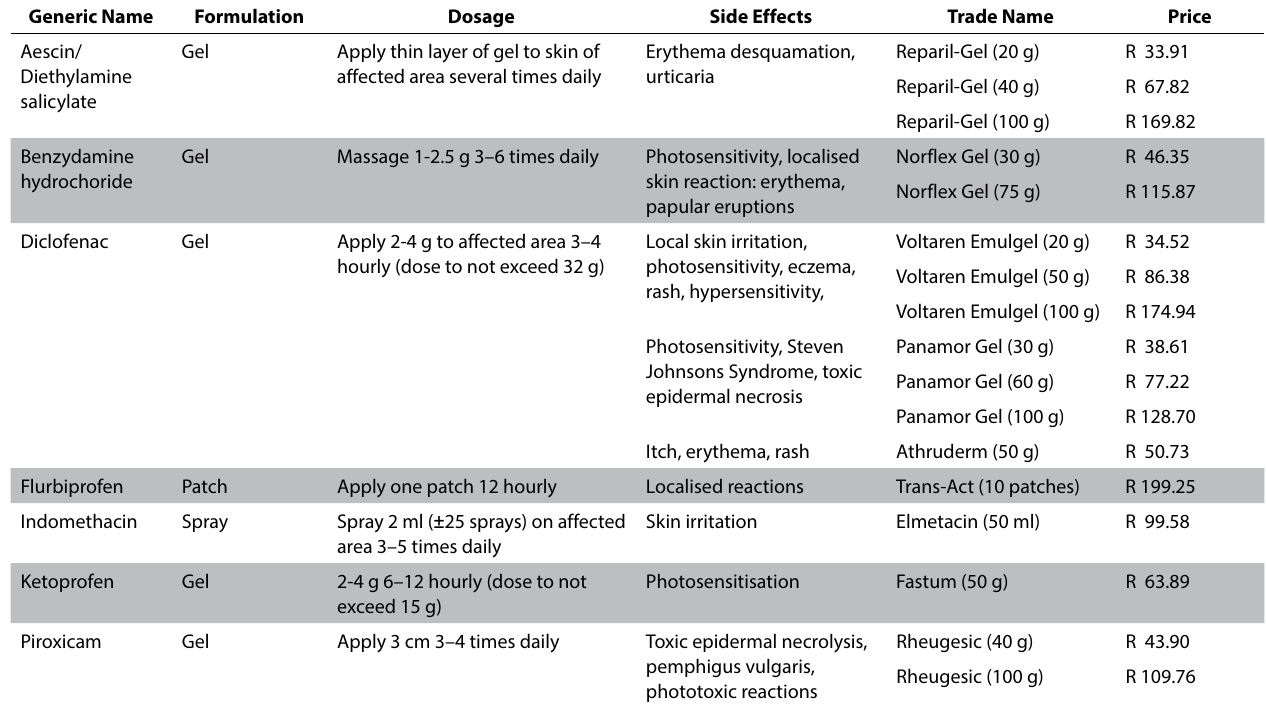
Table 7: Drug, formulation and dosages of various transdermal